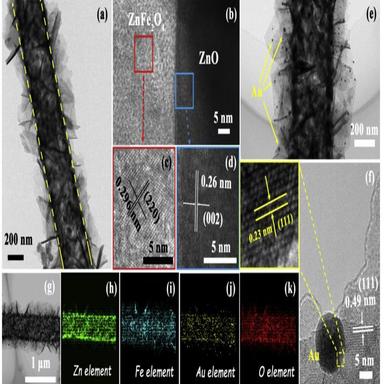
(a) Typical TEM image of doubleshelled ZnO/ZnFe2O4 heterostructure; (b–d) HRTEM images taking from the interface of ZnO/ZnFe2O4 heterostructure; (e) typical TEM image of ZnO/ZnFe2O4/Au composites; (f) HRTEM images taking from the edge of ZnO/ ZnFe2O4/Au heterostructure; (g–k) STEM image and corresponding elemental mapping of ZnO/ZnFe2O4/Au heterostructure.